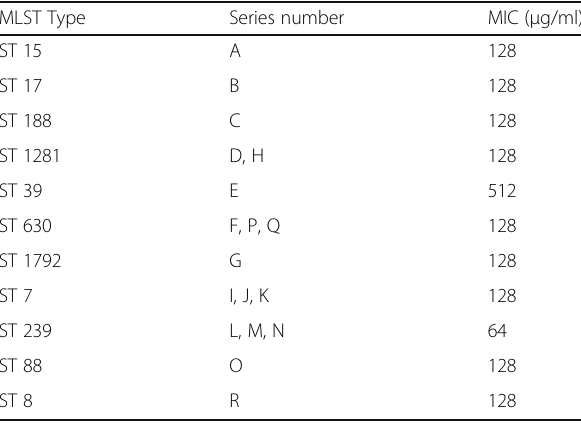
Table 3 MLST and Berberine MIC values of 18 clinical